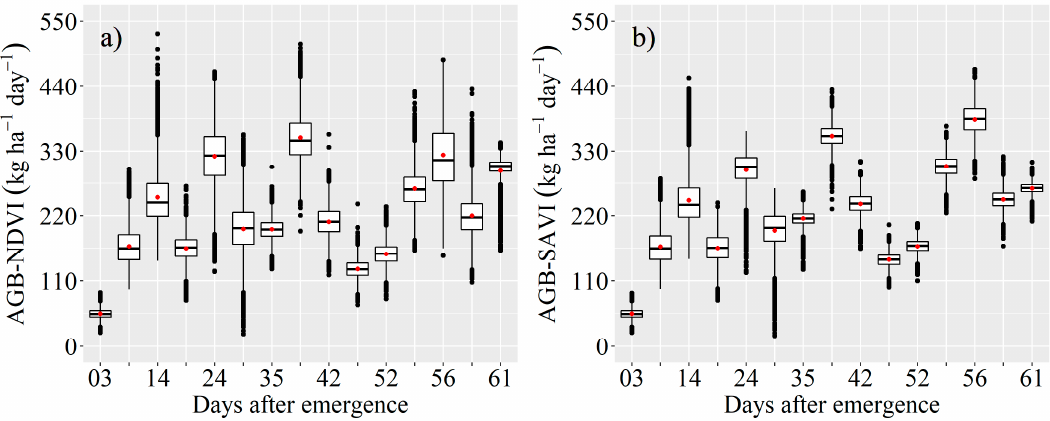
Figure 11. Descriptive statistics for the daily increase in aboveground dry biomass using the models derived from the NDVI ( a ) and SAVI ( b ).